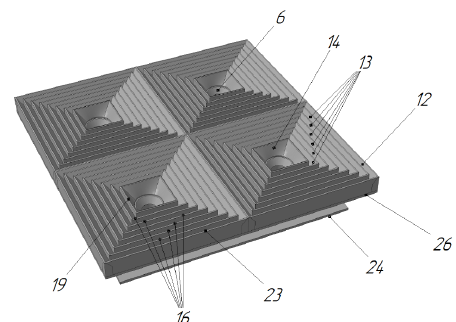
Figure 40. Landing platform for a UAV with a running wave funnel as an example of combined active and passive positioning [66] by Innopolis University. 13, funnel tiers’ 16, funnel tier